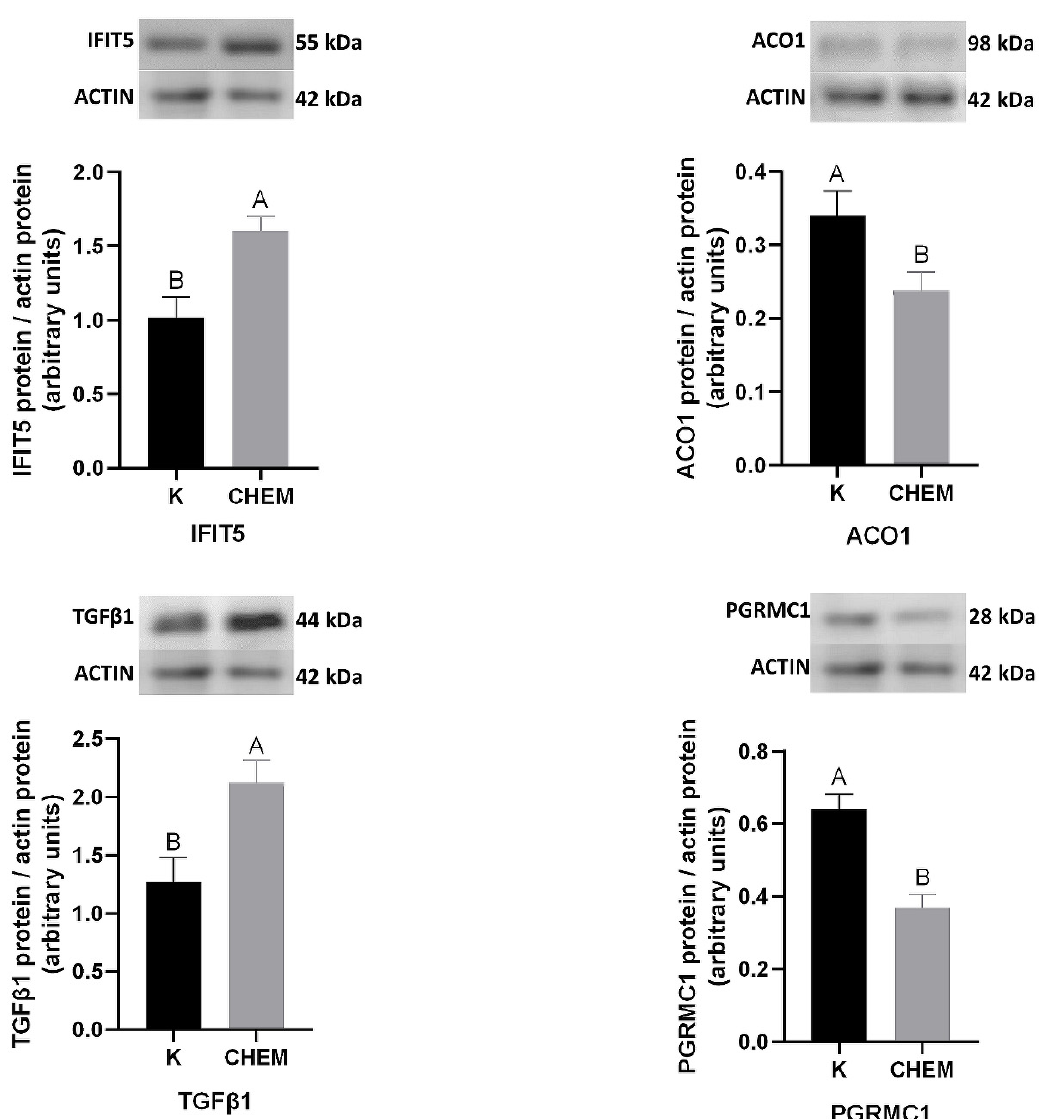
Figure 4. Western blot validation of the LC-MS results for differentially regulated proteins under the CHEM influence in the endometrium. Validation was performed for IFIT5, ACO1, TGF β 1 and PGRMC1 proteins with reference protein (actin) ( p -value < 0.05). Data are presented as the mean ± standard error of the mean (n = 5). Bars with different letters are significantly different at p < 0.05. K—samples from the control groups; CHEM—samples from the CHEM-treated groups. IFIT5—Interferon Induced Protein With Tetratricopeptide Repeats 5; ACO1—Aconitase 1; TGF β 1—Transforming Growth Factor Beta 1; PGRMC1—membrane-associated progesterone receptor component